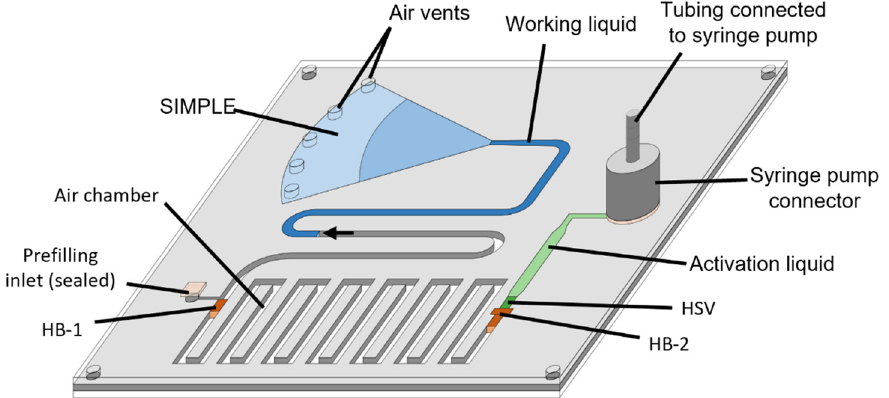
Figure 2. Chip design of a working chip as used for the SIMPLE pressure generation measurements. A syringe pump was used to push the activation liquid (green) towards the hydrophilic stop valve (HSV), which activated the SIMPLE operation by pushing the working liquid (blue) into the filter paper (indicated by the black arrow at the receding liquid front). By effect, the air in between the hydrophobic barriers HB-1 and HB-2 (orange) expanded as quantified by following up the working liquid volume.